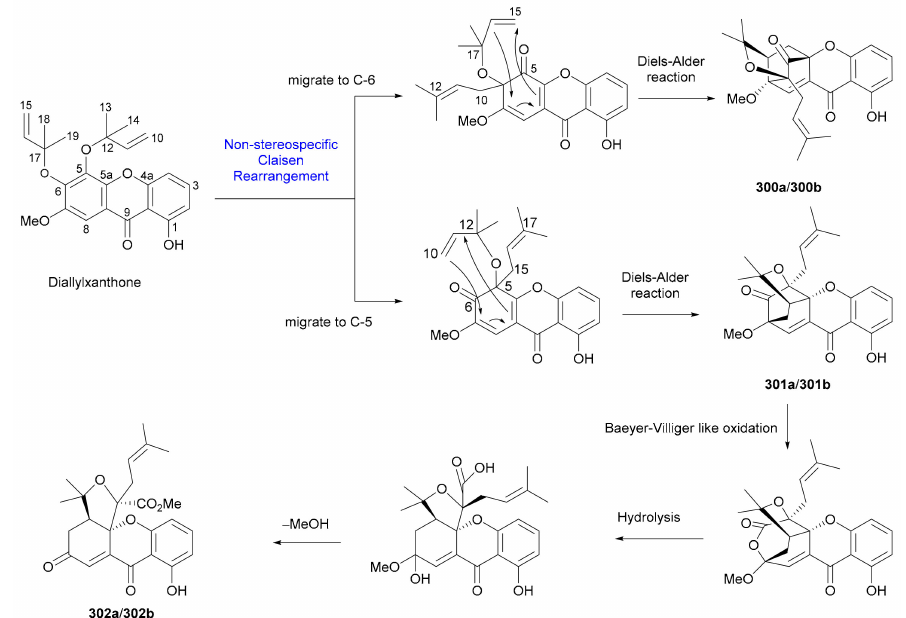
Scheme 4. Plausible biosynthetic pathways for 300a / 300b − 302a / 302b